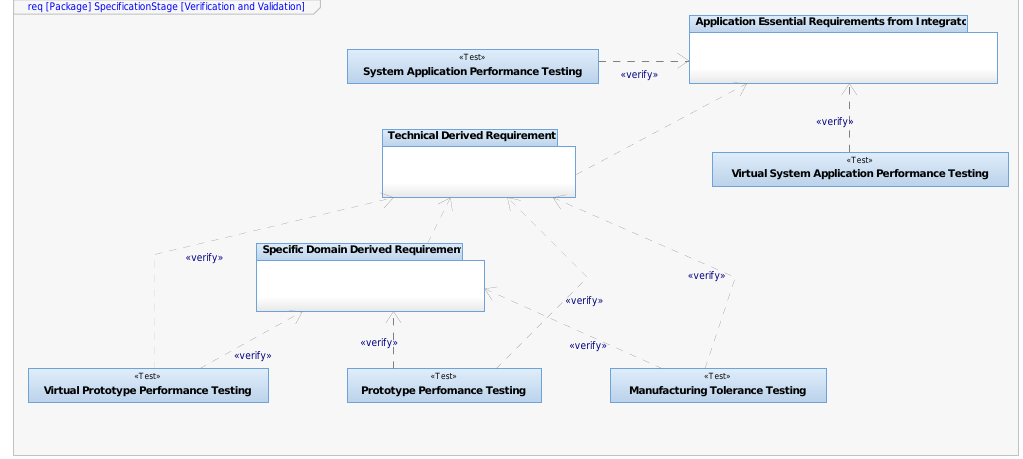
Figure 8. Generalized tests and verification of requirements.